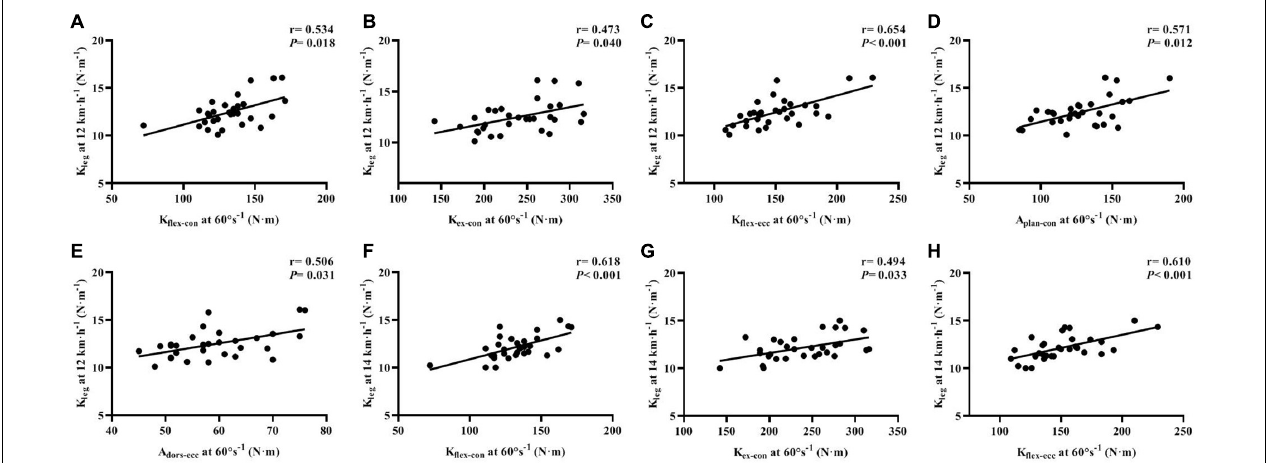
FIGURE 4 | Correlations of isokinetic lower-limb joint strength and IMTP force-time characteristics with leg stiffness at running speeds of 12 and 14 km · h − 1 (A–H) . K flex − con , knee flexor muscles peak torque in concentric action; K ex − con , knee extensor muscles peak torque in concentric action; K flex − ecc , knee flexor muscles peak torque in eccentric action; K ex − ecc , knee extensor muscles peak torque in eccentric action; A plan − con , plantar flexor muscles peak torque in concentric action; A dors − ecc , dorsiflexor muscles peak torque in eccentric action; IMTP, isometric mid-thigh